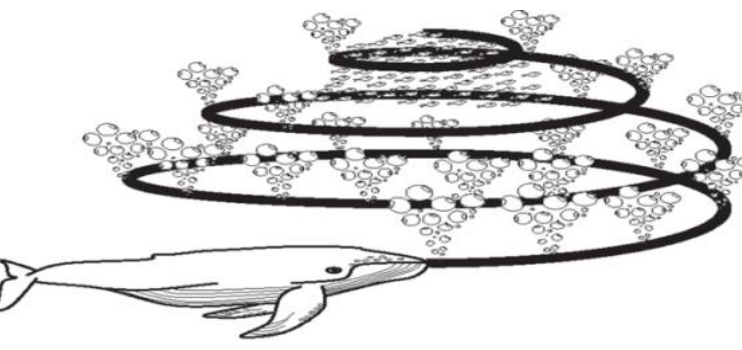
Figure 3. Bubble Net Feeding Humpback